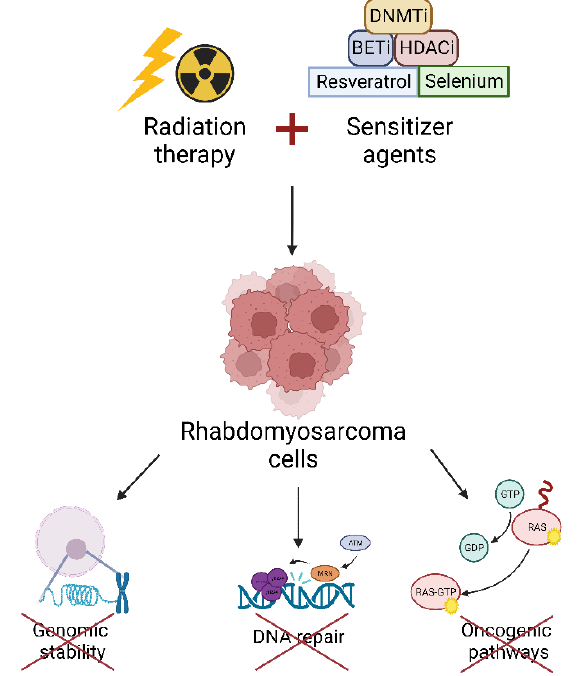
Figure 1. The combination of radiation therapy and sensitizer agents able to target epigenetic enzymes, transcription factors etc., sensitizes RMS cells to ionizing radiation by impairing genomic stability, DNA repair, and oncogenic pathways. DNMTi: DNA Methyltransferase inhibitors; BETi: Bromo- and extra-terminal domain inhibitors; HDACi: Histone Deacetylase inhibitors.